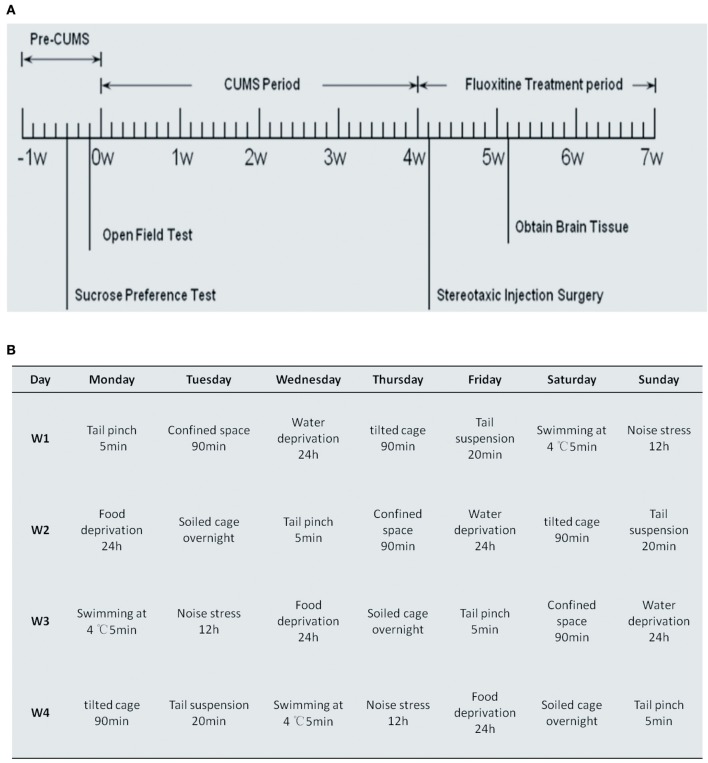
Process diagrams for experimental procedures and daily stressful events of CUMS rat model. (A) Process diagram for the experimental procedure, which is in accordance with that described in the Materials and Methods Section. The behavioral tests, including the open field test and the sucrose consumption test, were measured before CUMS, after CUMS and 1 day before sacrifice. Stereotaxic injection of miR-16 and the vector were conducted 4 weeks into CUMS. Cont1, CUMS1, Vector and miR-16 groups were sacrificed 1 week after the injection. Fluoxetine treatment was given periodically after CUMS, and continued for 3 weeks. Cont2, CUMS2, Vehicle and Fluoxetine groups were sacrificed after behavioral tests. (B) Process diagrams of daily stressful events of CUMS rat model. Rats in each group, except for the control group, were exposed to this.